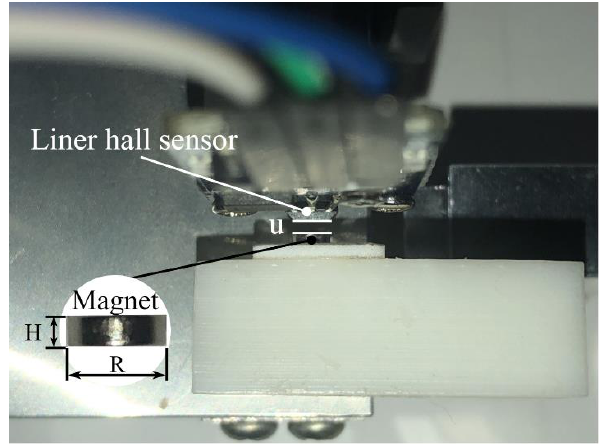
Figure 4. Hall element and magnet position.